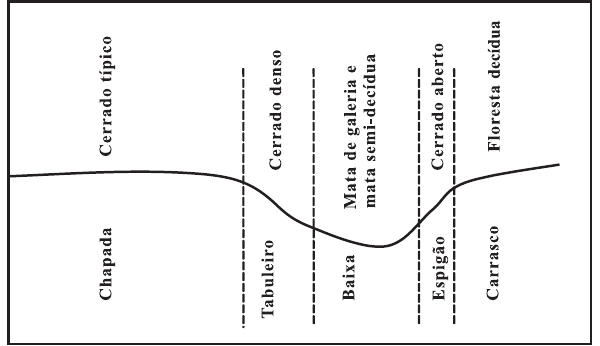
Figura 2. Esquema da posição dos diferentes ambientes na paisagem reconhecidos pelos agricultores e extrativistas, com as respectivas